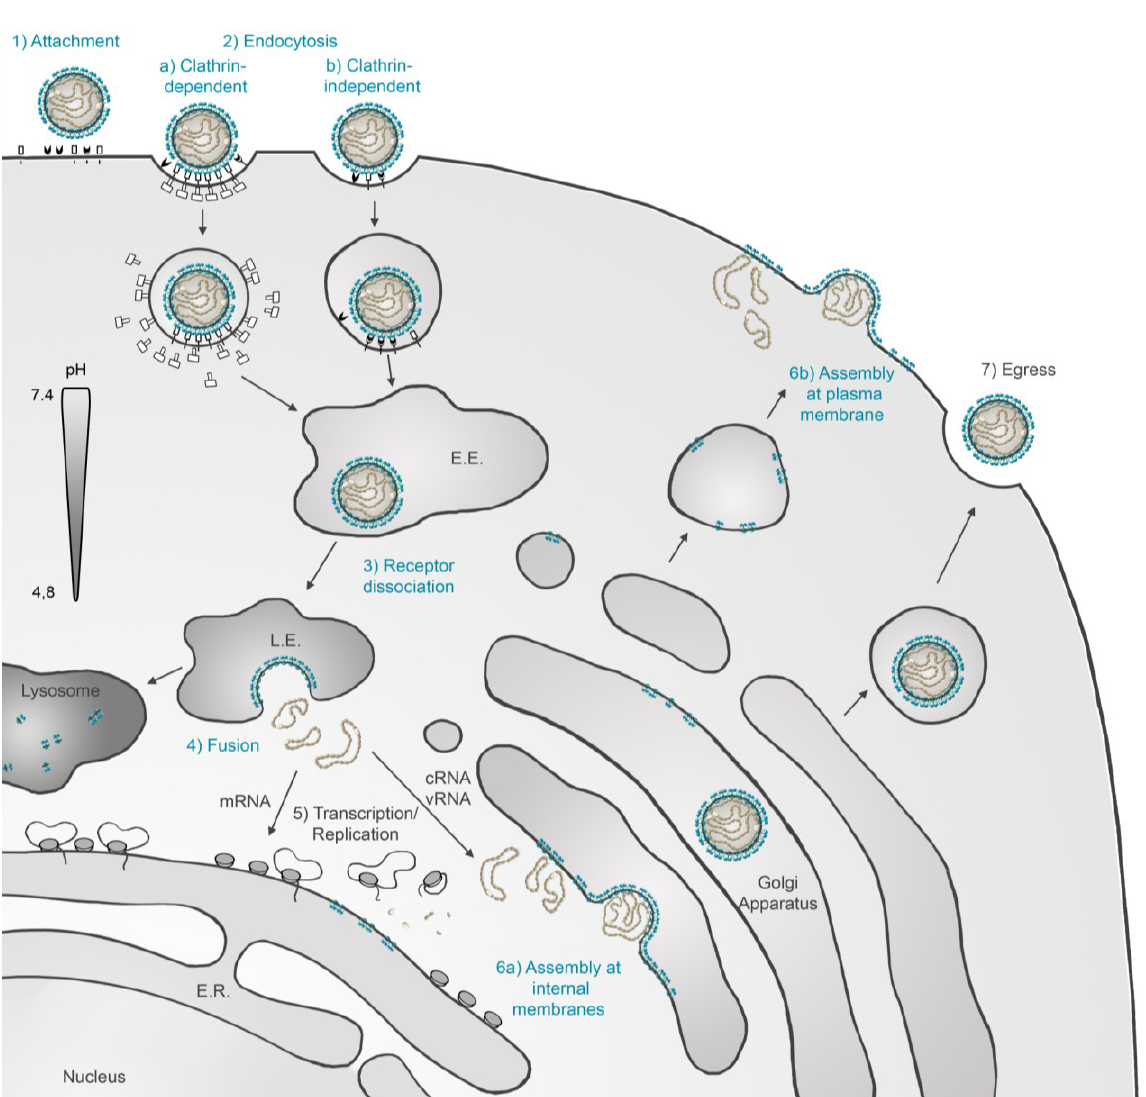
Figure 2. Functions of Hantavirus Envelope Glycoproteins during Virus Life Cycle. Once hantavirus particles attach to cell surface receptors by one, or both glycoproteins (1) they are uptaken by clathrin-mediated endocytosis (2a) or alternatively by other pathways that do not involve clathrin (2b). After virus particle uptake, the viral glycoproteins dissociate at one point from cellular receptors (3). Virus particles traffic down through the endocytic pathway until the low pH of endosomes, and possibly other cellular factors, trigger the Gc-mediated virus-cell membrane fusion process, releasing RNCs to the cytosol (4). After the transcription/replication of the viral genome and the synthesis of new viral proteins have taken place (5), the glycoproteins accumulate at internal membranes, where they can mediate virus assembly and budding (6a) and egress through the secretory pathway (7). Alternatively, new viruses may assemble and bud directly from the plasma membrane (6b). E.E. indicates early endosome, L.E. indicates late